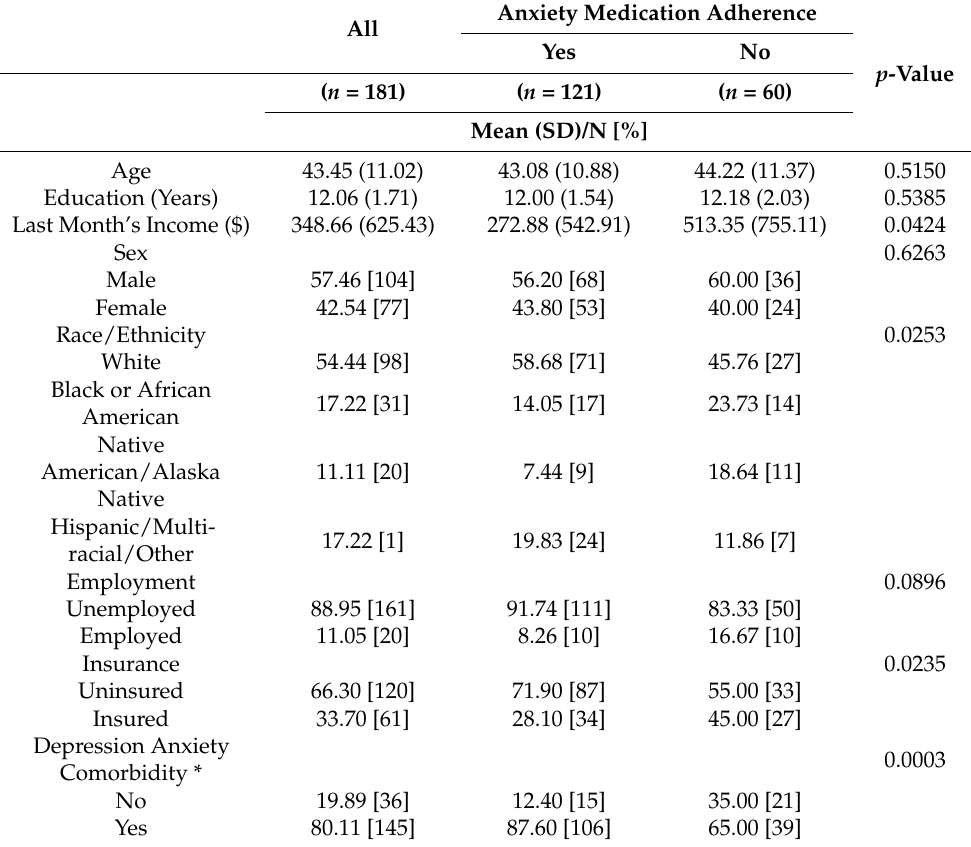
Table 3. Participant Demographics by Anxiety Medication Adherence